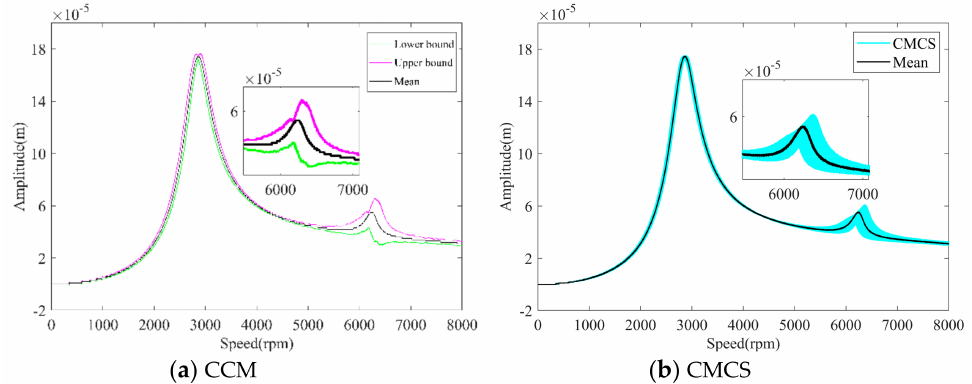
Figure 8. Deflection of the dual-disk rotor with stiffness uncertainty.